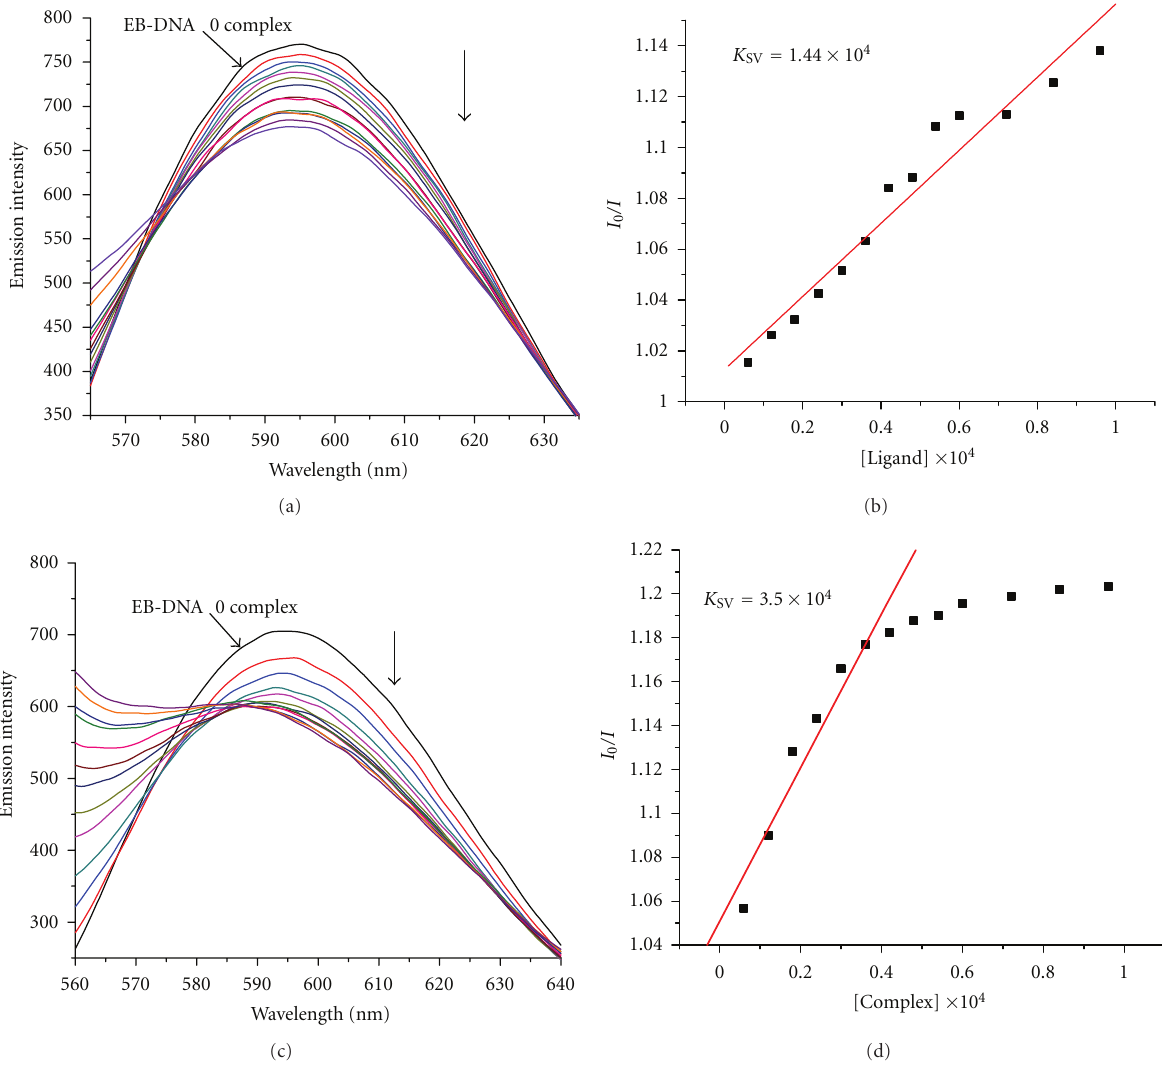
Figure 3: Emission spectra of EB bound to CT-DNA in the presence of the ligand babb (a), Cd (II) complex (c), [Complex] = 3 × 10 − 5 M; λ = 520 nm. The arrows show the intensity changes upon increasing concentrations of the complex. Fluorescence quenching curves of EB ex bound to CT-DNA by the ligand babb (b), Cd (II) complex (d). (Plots of I 0 /I versus